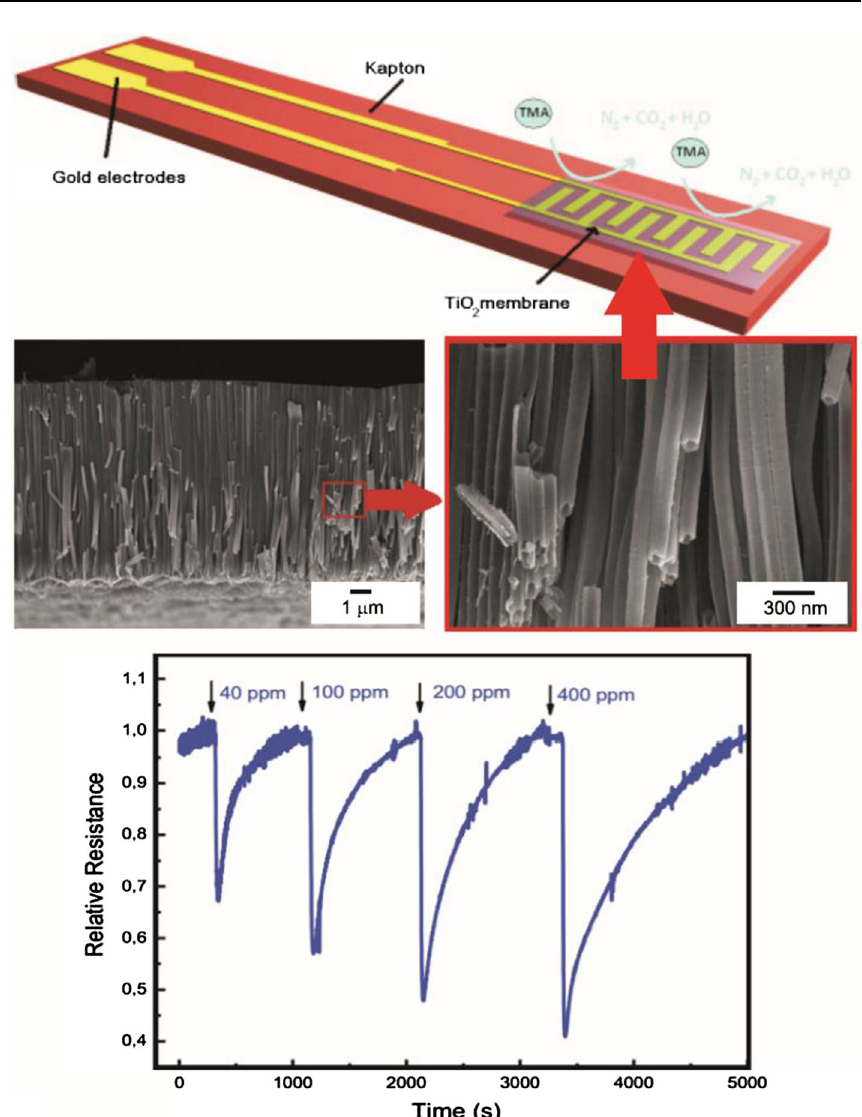
Fig. 3 Schematic of the flexible gas sensor based on TiO membrane nano- 2 tubes prepared by anodiza- tion process. The SEM images of the nanostructures is presented together with the response of the sensor to TMA. Reproduced from [78] with permission of